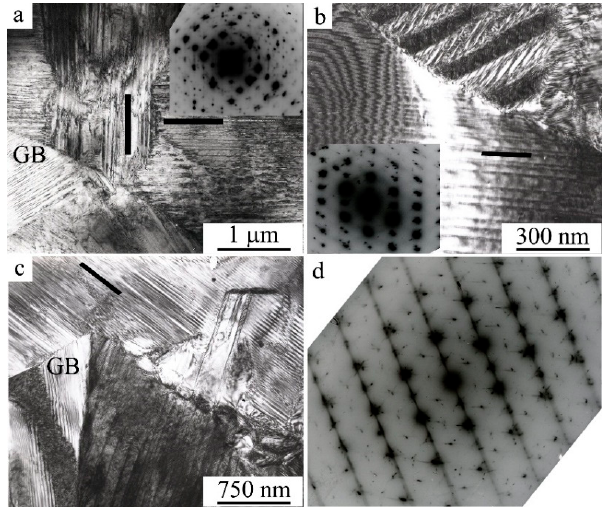
Figure 8. TEM images of the microstructure and the corresponding SAED of alloys Ni 49.5 Ti 50.5 − x Zr x : ( a ) x = 3 at.%, ( b ) x = 10 at.% and ( c , d ) x = 15 at.%. ( a ) x = 3 at.%, ( b ) x = 10 at.% and ( c , d ) x = 15 at.%.